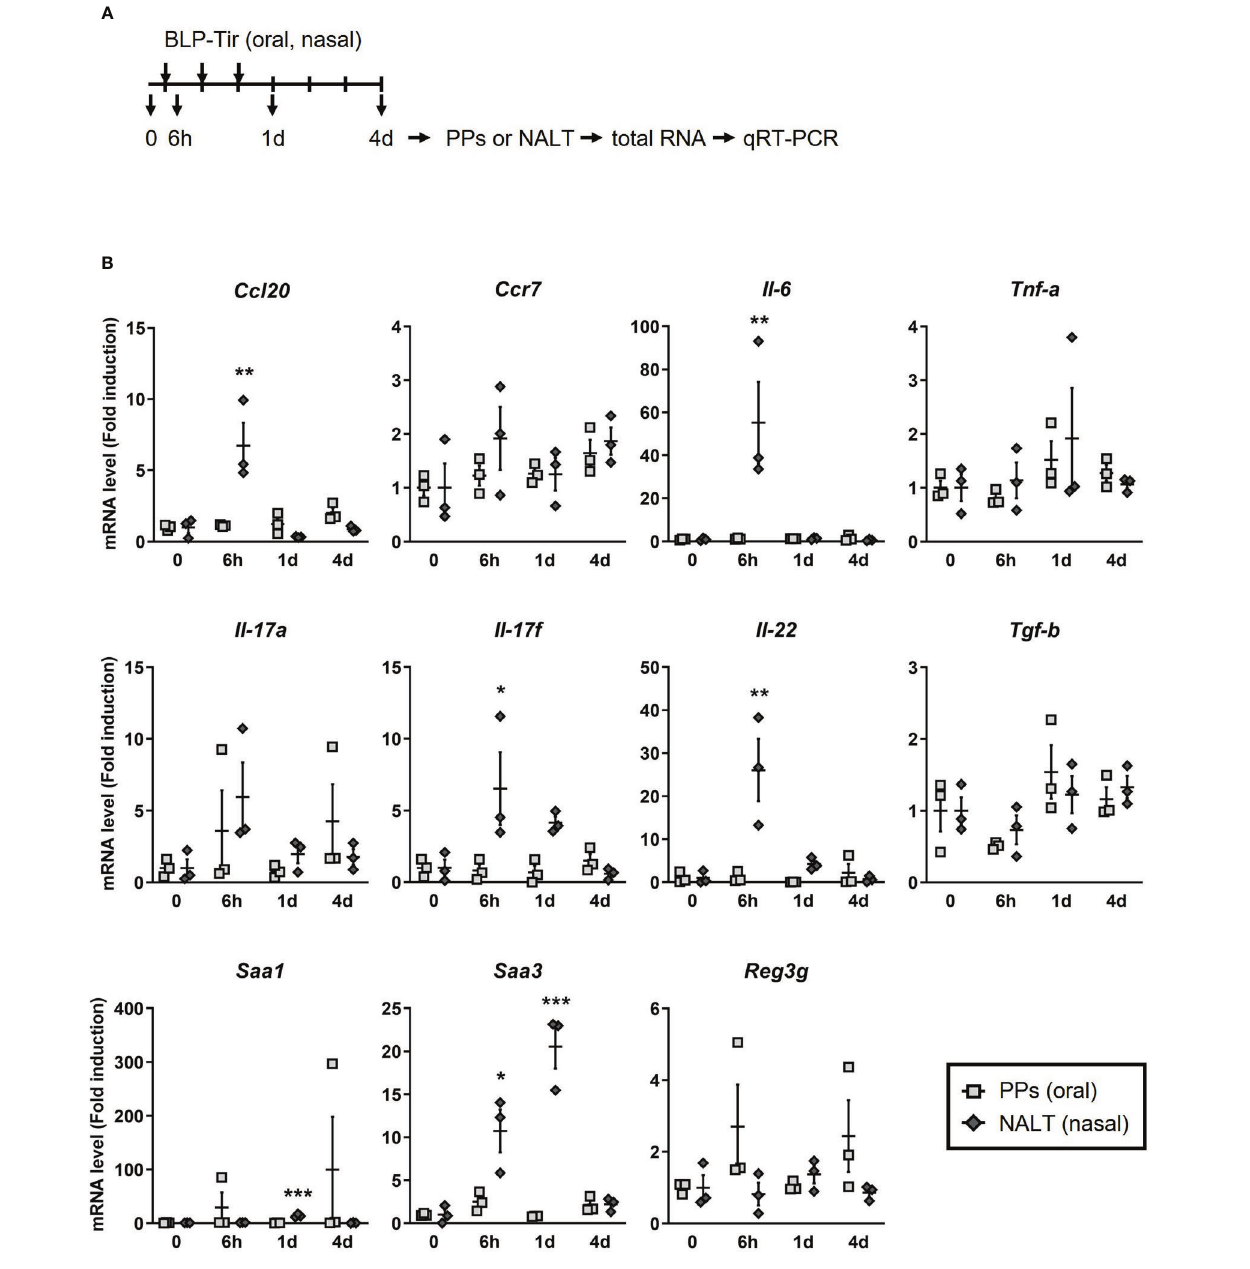
FIGURE 6 Kinetics of cytokines/chemokines gene expression in mucosal lymphoid tissues. (A) Design of the experiment. Mice were administered with BLP-Tir orally or nasally for 3 consecutive days. Total RNA was extracted from the PPs or the NALT from mice administered with BLP-Tir orally or nasally, respectively, before (0) and at 6 h after the 1 st administration, and at 1 and 4 days (1d and 4d) after the 3 rd administration (n =3/group). (B) mRNA levels of the indicated genes were measured by qRT-PCR and expressed as fold induction (means ± SEM, n=3). Gapdh was used as an internal control. *, p<0.05; **, p<0.01; ***, p<0.001; one-way ANOVA followed by Dunnett ’ s multiple comparison test were used to compare means from BLP-Tir administered groups against the control group (0, before